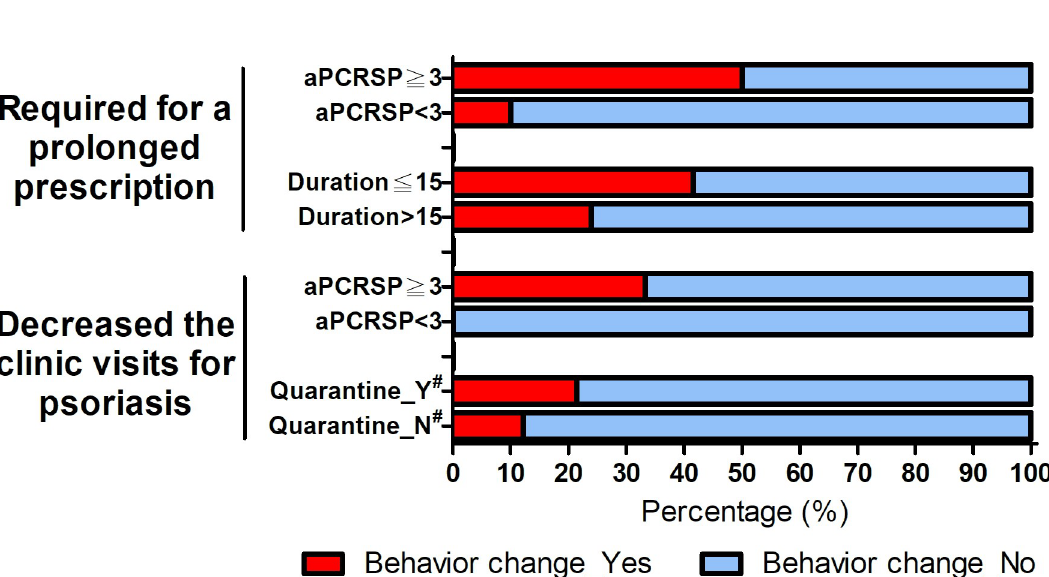
Fig 3. Healthcare-seeking behavior changes. Changes in healthcare-seeking behaviors in psoriasis patients during the COVID-19 pandemic among psoriasis patients stratified by perceived COVID-19-related risk (average PCRSP score, aPCRSP), duration of psoriasis, and friends or a family member with and without quarantine experience. � Quarantine_Y, Friends or a family member with quarantine experience, Quarantine_N, Friends or a family member without quarantine experience.